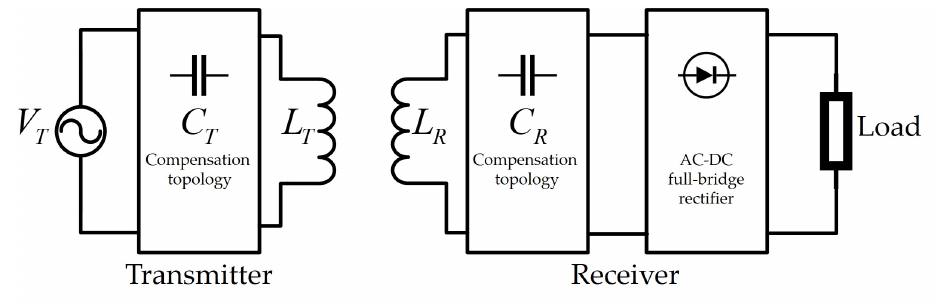
Figure 2. Typical structure of magnetic field-based